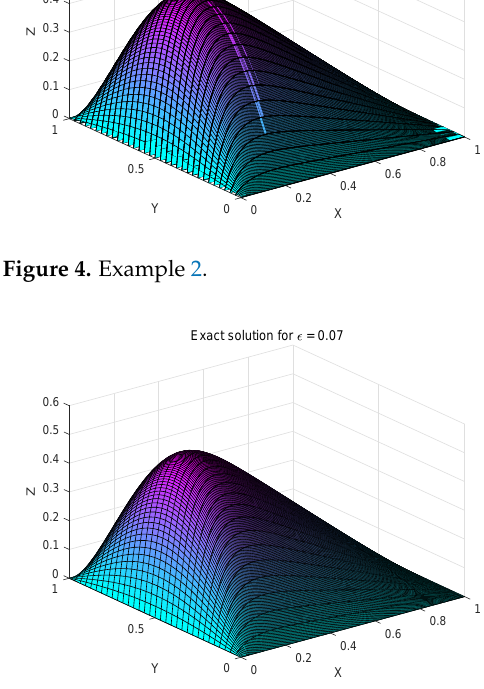
Figure 5. Example